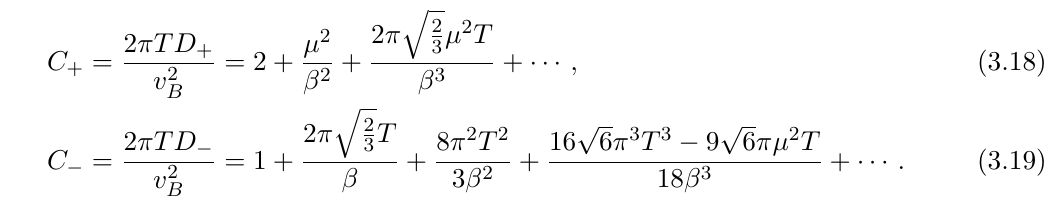
Figure 1 . Di(cid:11)usion constants of the linear axion model at (cid:12)nite density. (cid:22)=T = 0 : 1 ; 1 ; 5 from left to right. The blue curve is for D + and the red curve is for D (cid:0) . The green curve displays v 2 2 (cid:25)D (cid:6) =v 2 saturates the universal value in the incoherent regime: (cid:12)=T (cid:29) 1 and (cid:12)=(cid:22) (cid:29) 1. B which